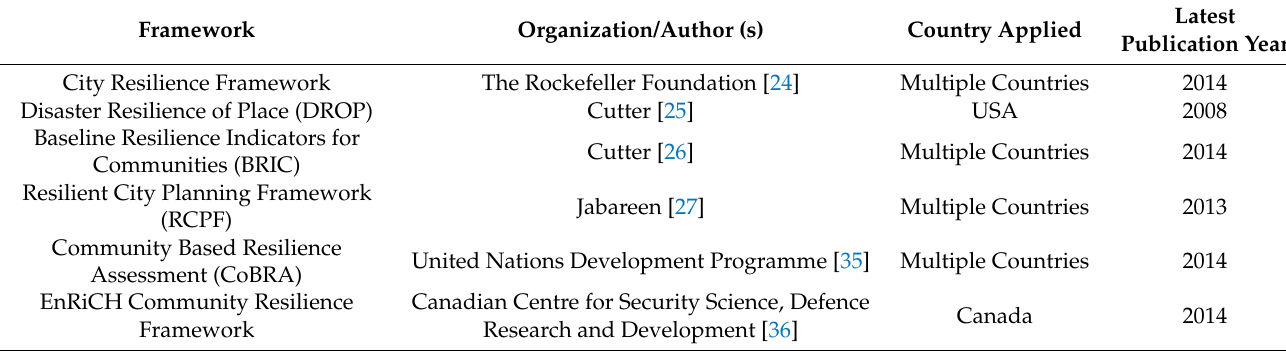
Table 1. Summary of general resilient city